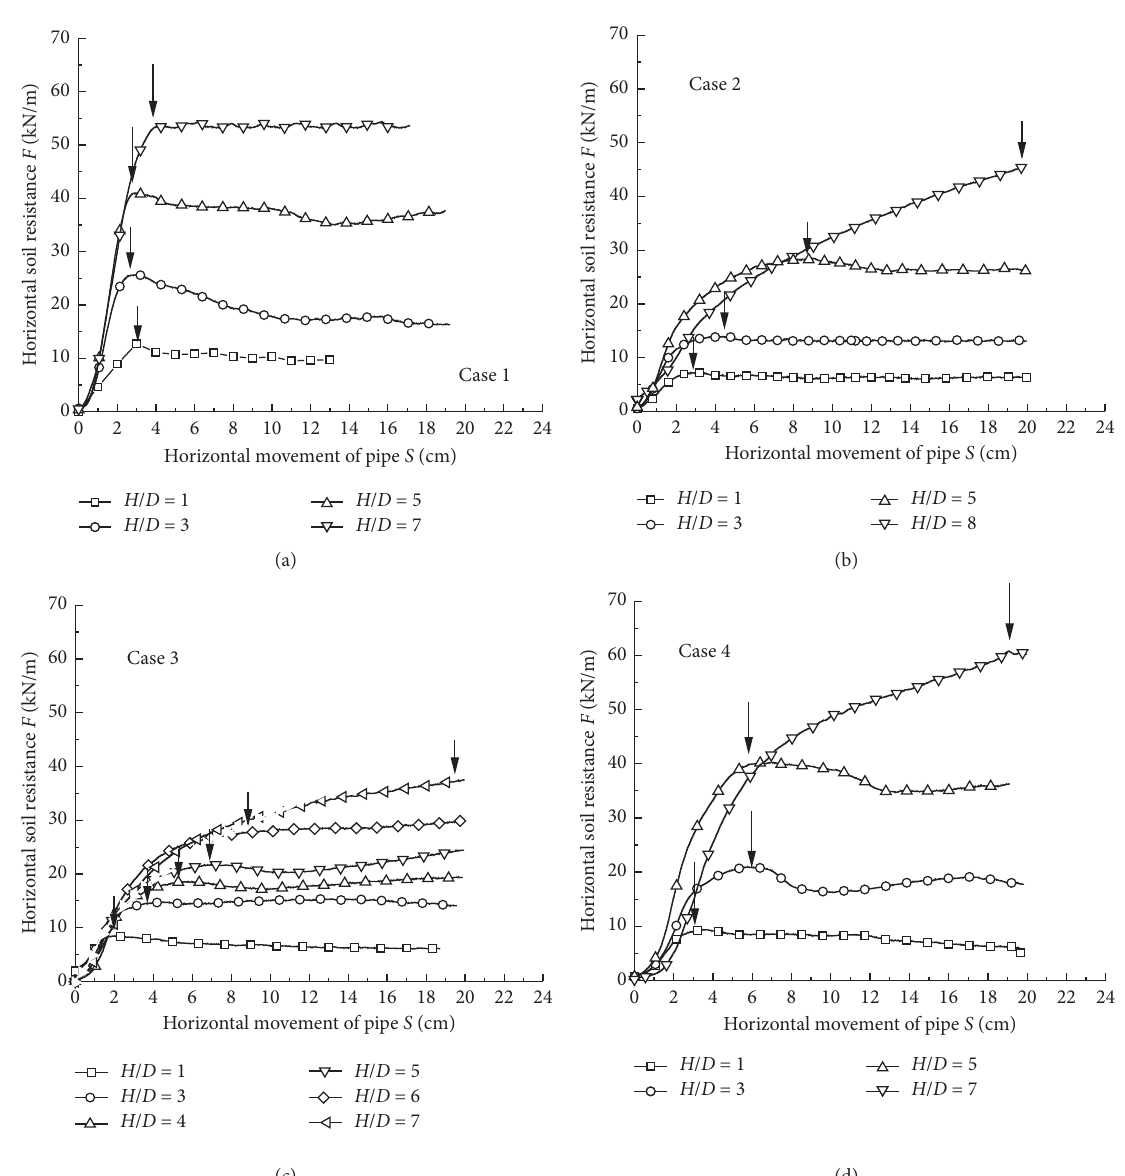
Figure 9: Relationship between lateral soil resistance and deformation. (a) Case 1, (b) Case 2, (c) Case 3, and (d) Case